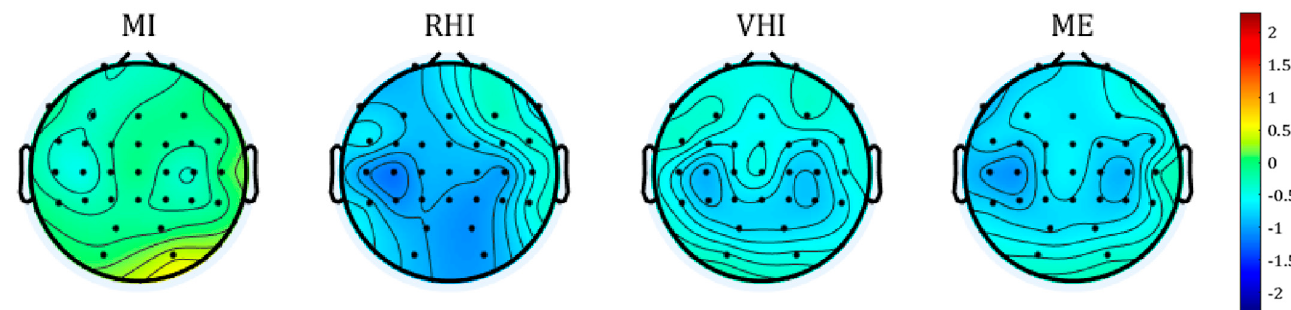
Figure 4. Topographic distribution of average ERSP for each paradigm, within a two-second window after the cue.